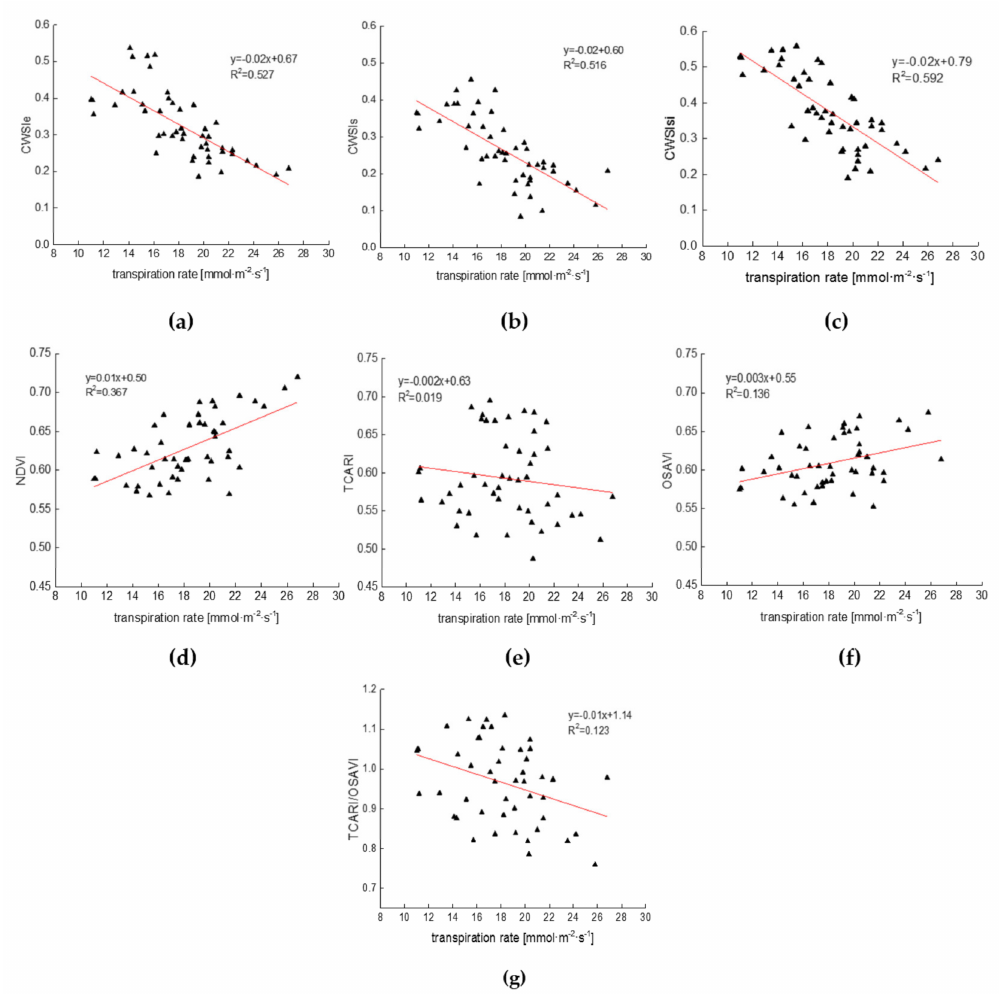
Figure 7. Relationship between stomatal conductance and ( a ) empirical CWSI (CWSIe), ( b ) statistical CWSI (CWSIs), ( c ) simplified CWSI (CWSIsi), ( d ) normalized difference vegetation index (NDVI), ( e ) transformed chlorophyll absorption in reflectance Index (TCARI), ( f ) optimized soil-adjusted vegetation index (OSAVI), ( g ) TCARI/OSAVI. Note: four days of data at plot level, n = 48. Table 3. Pearson’s correlation coefficients (R) for three CWSI types and the soil volumetric